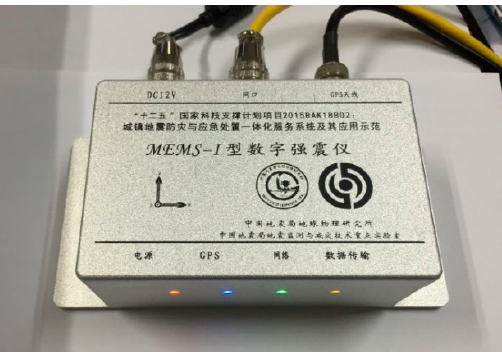
Figure 7. The MEMS seismic intensity rapid reporting instrument developed in this study.